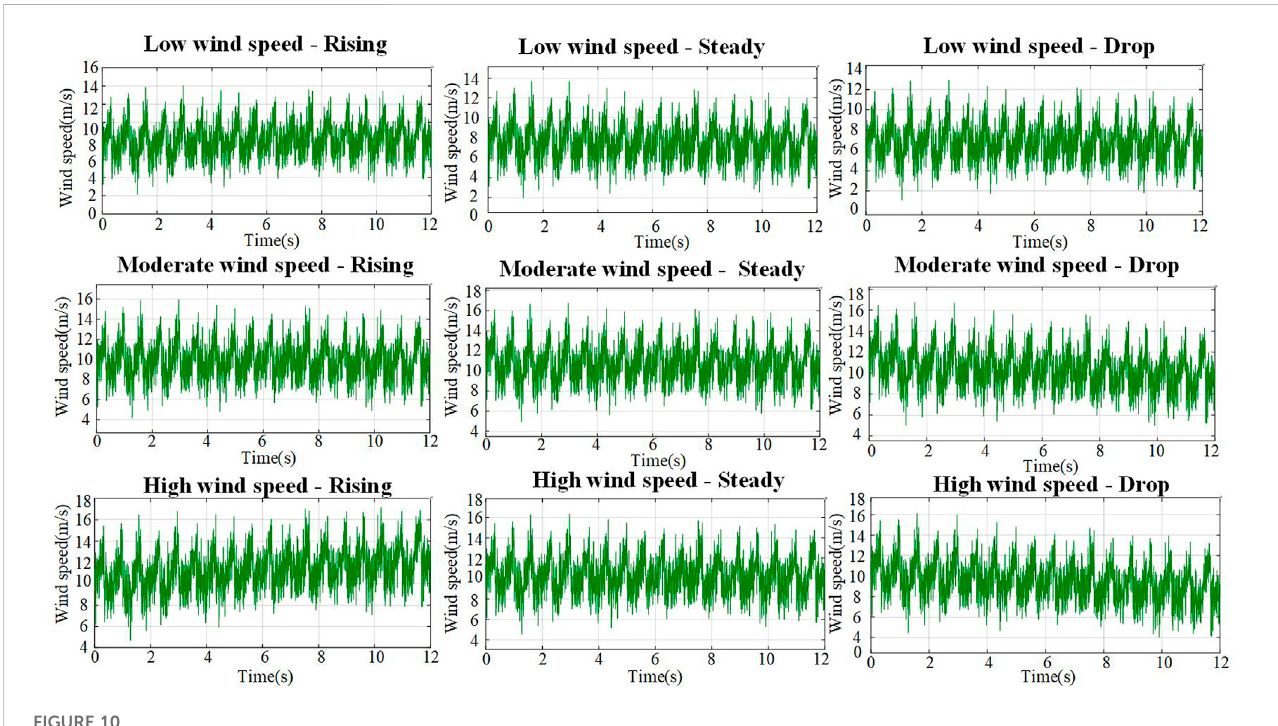
FIGURE 10 Different wind speed curves given for